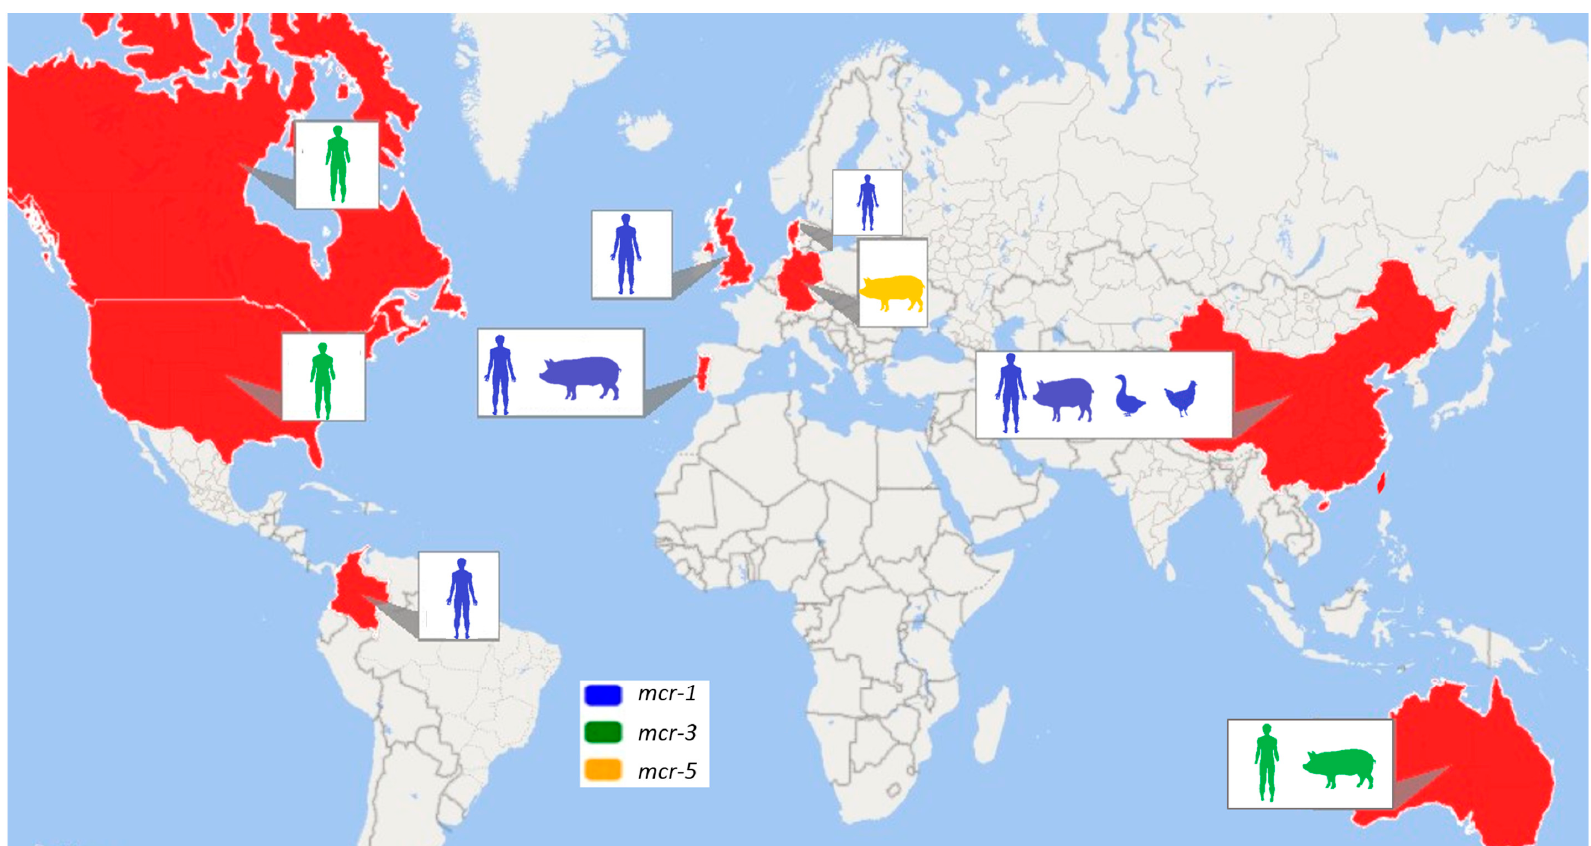
Figure 2. Global distribution of Salmonella Typhimurium ST34-carrying mobile colistin resistance ( mcr ) -1, mcr-3 , and mcr-5 colistin resistance genes [9–12,17–26]. This also shows the different sample sources from where mcr- carrying bacterial strains were obtained from different countries. In the non-red marked countries, no cases of Salmonella Typhimurium ST34-carrying mcr genes were reported.